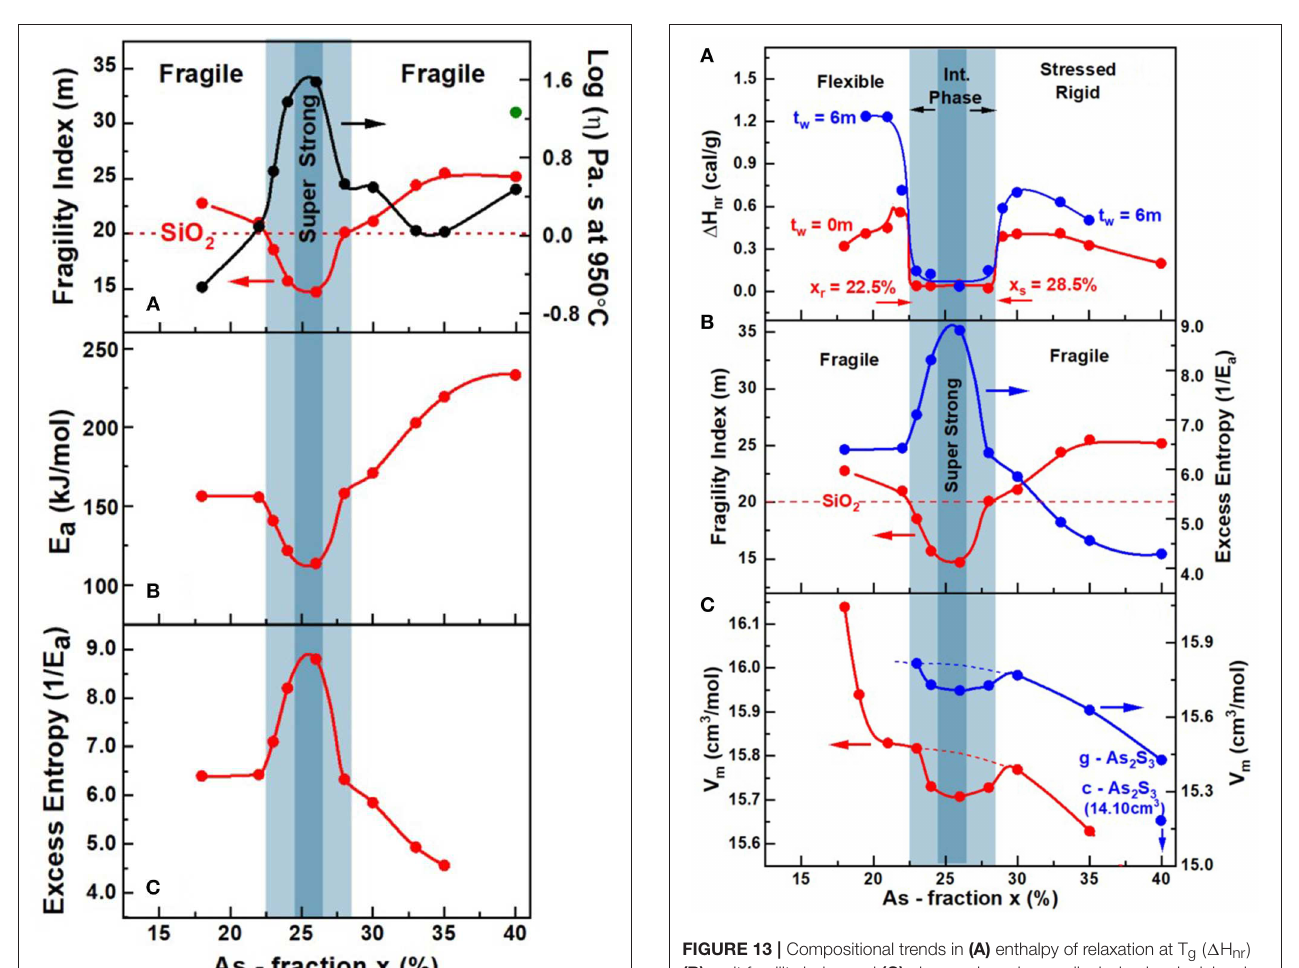
FIGURE 13 | Compositional trends in (A) enthalpy of relaxation at T g ( 1 H nr ) (B) melt fragility index and (C) glass molar volumes displaying local minima in the 22.5% < x < 28.5% range, the light blue panel. In (B) we also plot the inverse of the activation energy, E a , for enthalpy relaxation times. In (A) the light blue panel gives the glass reversibility window, (B) compositions for which m < 20 defines the fragility window, and in (C) the local minimum in molar Volumes illustrates the volumetric window in glasses. To better illustrate V m (x) results at x > 30%, we have redrawn the data on a coarser ordinate scale on the right to illustrate the reduction in V m in both g- and c- As 2 S 3 [14.10(2) cm 3 ] ( Robie and Bethke,